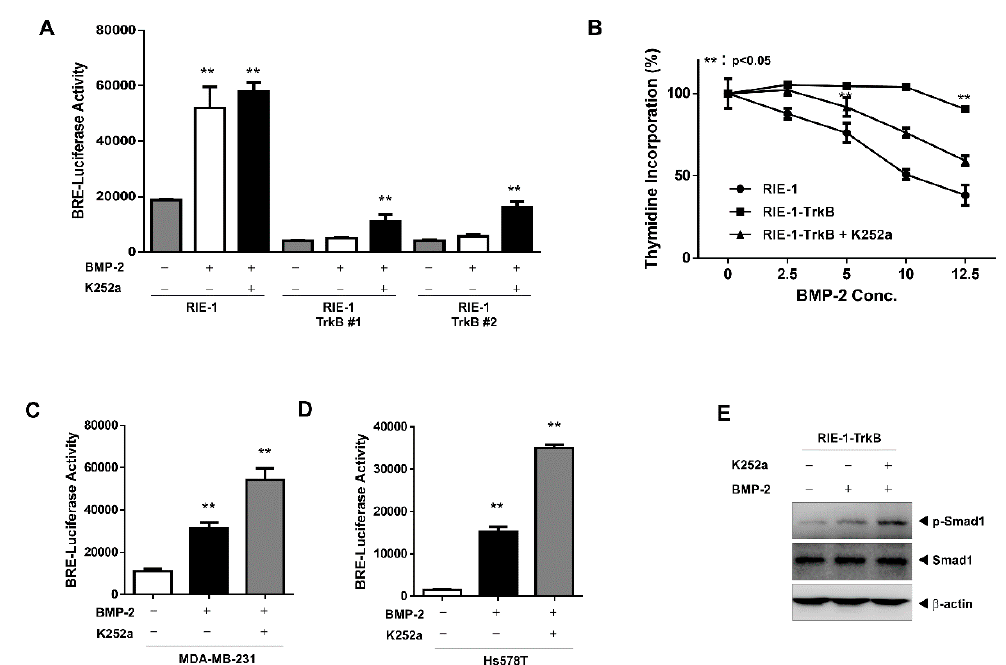
Figure 4. Tyrosine kinase activity of TrkB is required to inhibit BMP signaling. ( A ) BMP-2-responsive BRE Luciferase reporter activity in RIE-1 and RIE-1-TrkB cells following treatment with K252a (50 nM) and BMP-2 (5 ng / mL). Luciferase activity was measured 24 h after treatment with BMP-2 (5 ng / mL). ** Control versus treatment with K252a, p < 0.05, n = 3. ( B ) Thymidine incorporation assay of RIE-1 and RIE-1-TrkB cells treated with K252a (50 nM) and various BMP-2 concentrations. The points represent the means from three measurements ± SD. ( C , D ) BMP-2-responsive BRE Luciferase reporter activity in MDA-MB-231 and Hs578T cells treated with K252a (50 nM). ** Control versus treatment with BMP-2, p < 0.05, n = 3. ( E ) Western blot analysis of phospho-SMAD1 and SMAD1 expression in RIE-1 and RIE-1-TrkB cells with or without BMP-2 (5 ng / mL) or K252a (50 nM) treatment.